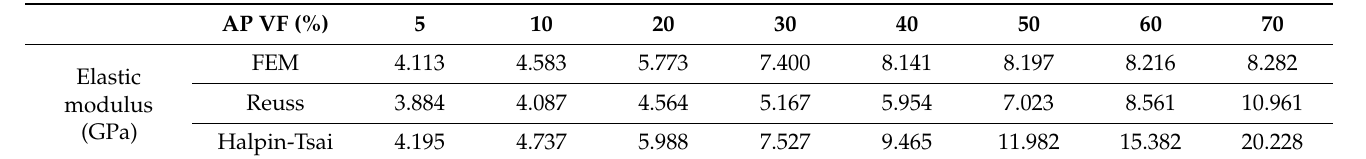
Table 4. FEM and numerical analysis predictions of elastic modulus.